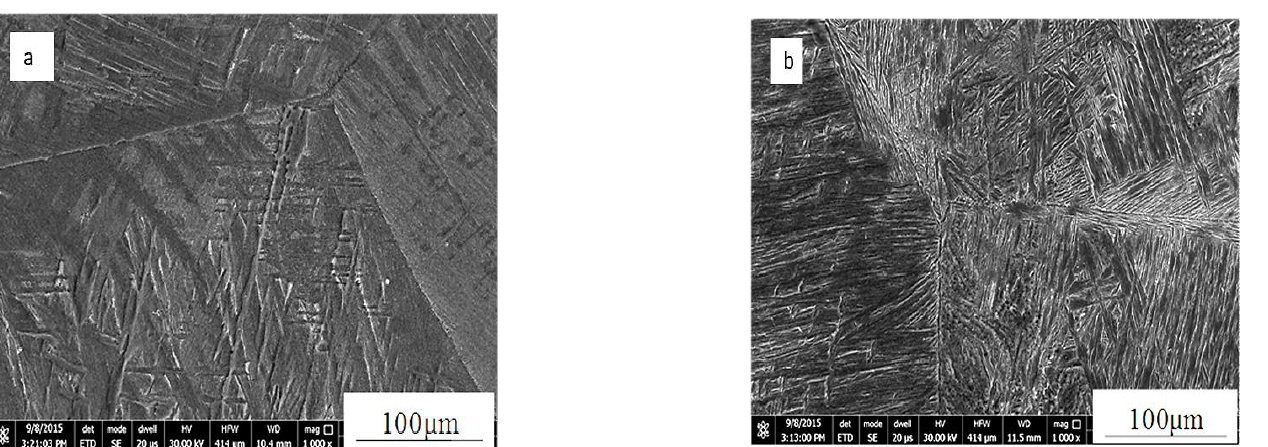
Figure 7. Images of machined surfaces at different cutting conditions. The SEM micrographs of the cross section of the machined Ti64 and Ti67 specimens under different cutting modes are shown in Figure 8a – f. The measurements of RL are also summarized in Figure 9. At rough cut (RC) the re-solidified or recast layer (RL) showed waving structure of variable thickness, which differs for the two alloys. In the case of Ti64, RL recorded the largest value around 30 ± 0.93 µm, Figure 9. This number declined sharply to half for Ti67. After the melted material is re-solidified, tensile stress distribution varies between the parent material and the top machined layer, leading to the generation of mi- cro-cracks on the machined surface. The machined surface contains both overlapped cra- ters that are resulted from the bombardment of ions induced due to the repetitive sparking